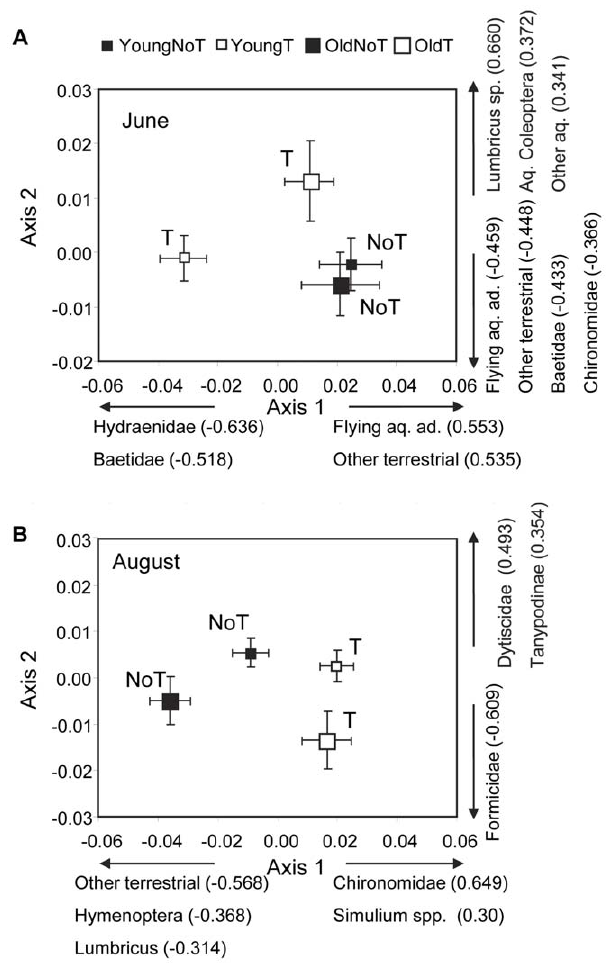
Figure 9. Trout diet. Canonical analysis of principal coordinates of diet composition data in (A) June and (B) August. Mean axis scores with SE values are shown for each treatment type (Young and Old indicates young and old fish, respectively, whereas T and NoT indicates terrestrial invertebrate reduction and no terrestrial invertebrate reduction treatments). Food items showing axis correlations $ 0.3 (Spearman’s rho in parenthesis; P , 0.05 in all cases) are indicated for each axis.